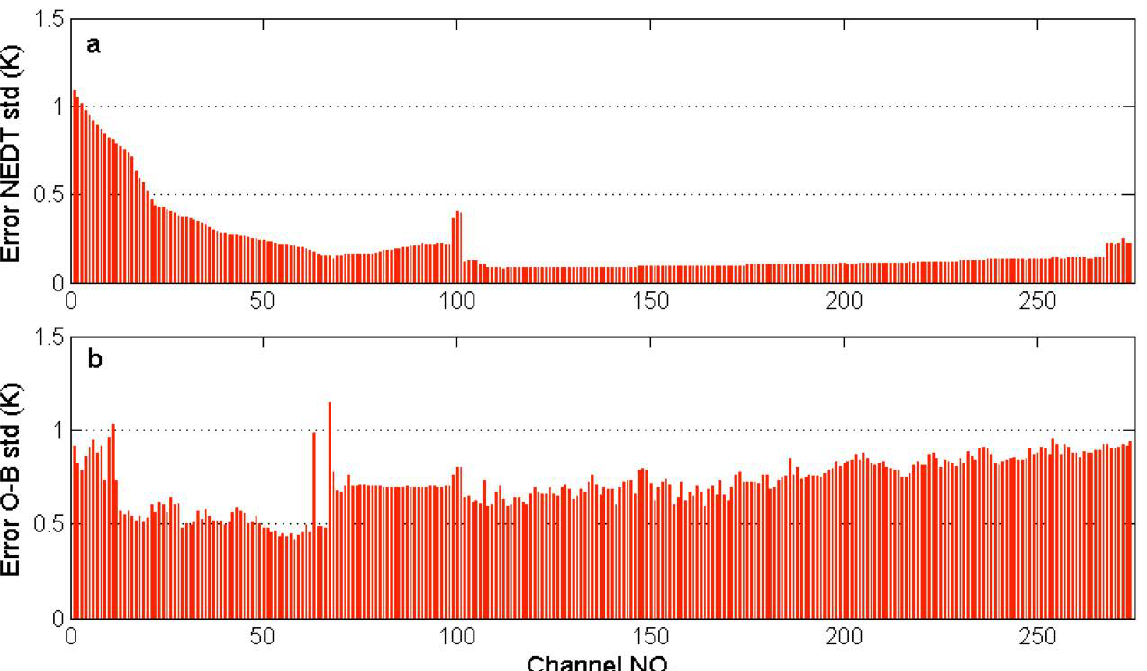
Figure 5. The instrument error ( a ) and simulation error ( b ) of the selected